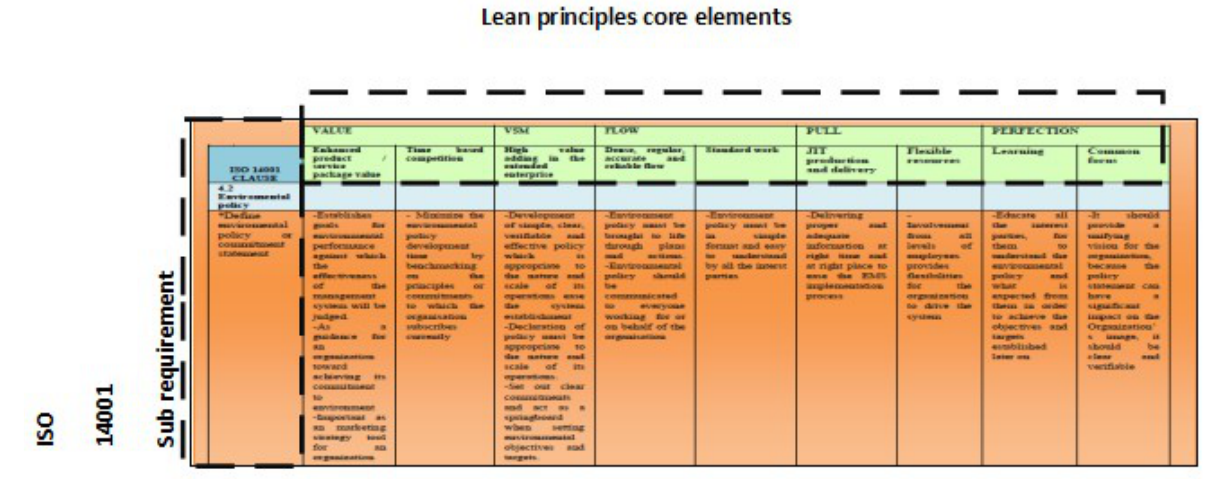
Figure 2. Integration uses Cross tabulation